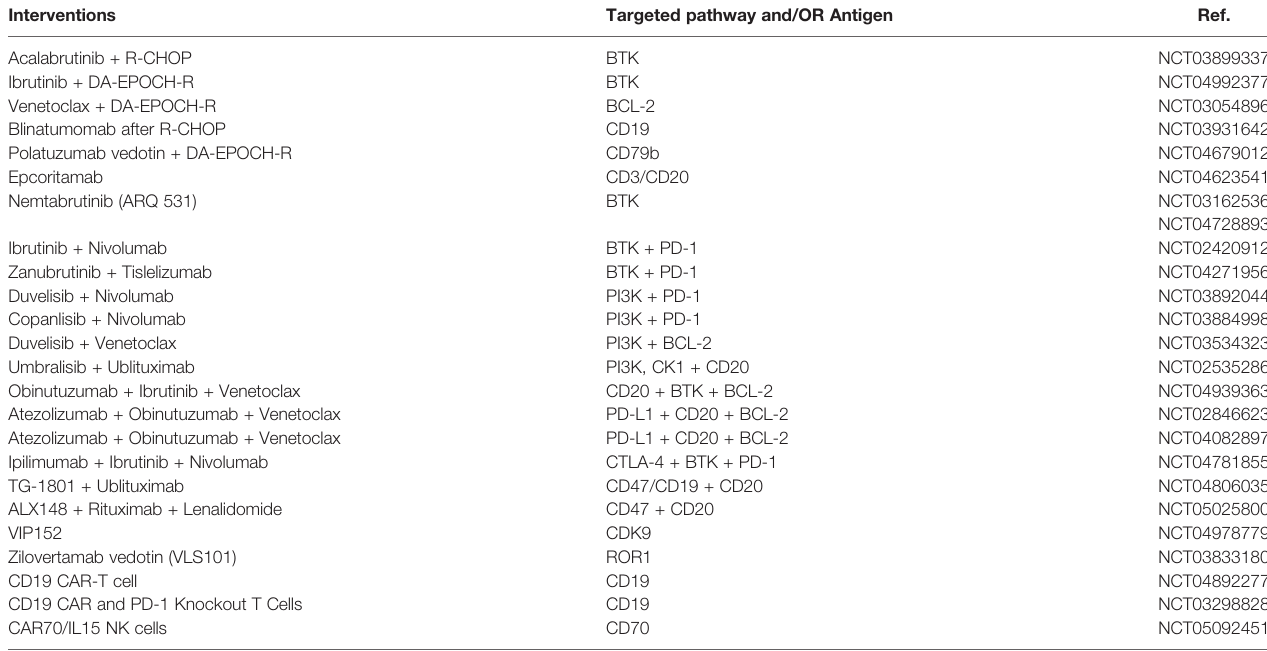
TABLE 2 | Ongoing trials with targeted agents in diffuse large B-cell Richter